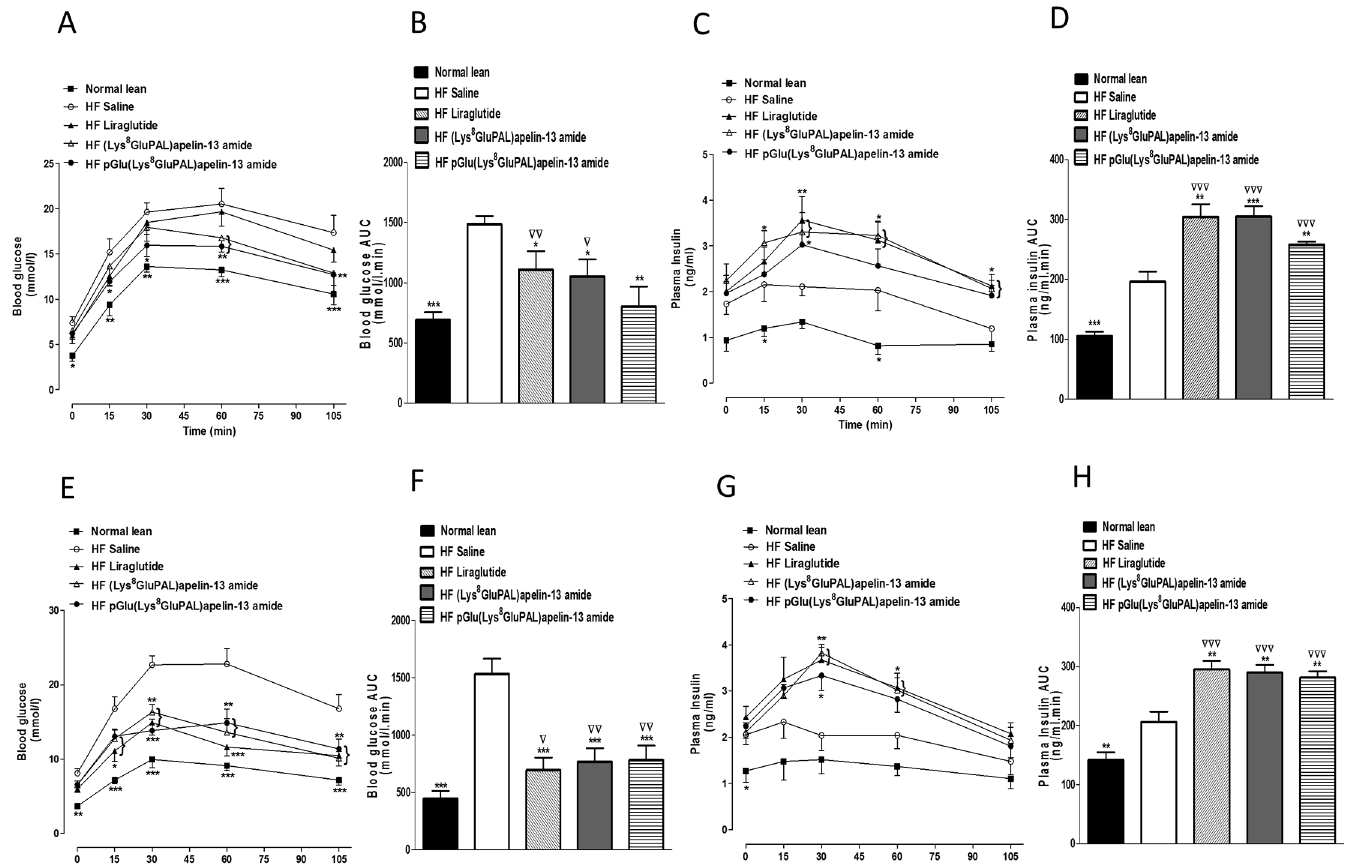
Fig 2. Effect of once daily i.p. administration of liraglutide, (Lys 8 GluPAL)apelin-13 amide or pGlu(Lys 8 GluPAL)apelin-13 amide (each at 25 nmol/kg) on blood glucose and plasma insulin responses to an intraperitoneal (A-D) or oral (E-H) glucose challenge in 18 h fasted high-fat fed mice after 18 hours of fasting. After 28 days, blood glucose (A and E) and plasma insulin concentrations (C and G) were measured before and after administration of glucose (18 mmol/kg body weight). Blood glucose and integrated plasma insulin responses (area under the curve; AUC, 0–105 min) are also shown. Values represent mean ± S.E.M. (n = 8) where (cid:3) p < 0.05, (cid:3)(cid:3) p < 0.01 and (cid:3)(cid:3)(cid:3) P < 0.001 is compared to high-fat fed saline treated mice, 5 p < 0.05, 55 p < 0.01 and 555 p < 0.001 is compared to lean mice fed on a normal diet.